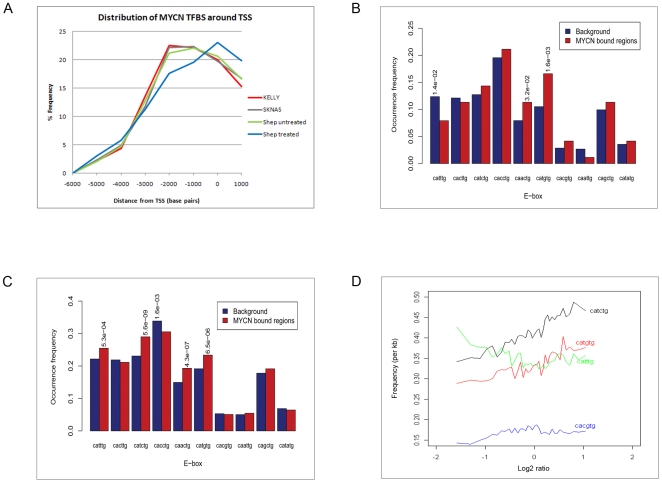
Distribution of MYCN transcription factor binding and E-box preference.(A) Percentage of MYCN binding sites around transcription start sites. X-axis displays the distance in base pairs from UCSC annotated transcriptional start sites. Y-axis represents the percentage frequency of positive MYCN binding sites identified in each neuroblastoma cell line. (B) Prevalence of E-box motifs within MYCN binding sites detected by ChIP-chip across all cell lines and both antibodies. Statistically significant bars are indicated with their respective p-values (C) Prevalence of E-box motifs within the MYCN binding sites detected by ChIP-chip in the MYCN-amplified state only. Statistically significant bars are indicated with their respective p-values. (D) Association of E-box frequency with raw fluorescent ratios in MYCN binding sites on the promoter array which were detected in the Kelly NB cell line. The number of E-boxes per kilobase (y-axis) is plotted against the raw array fluorescent ratio intensities.